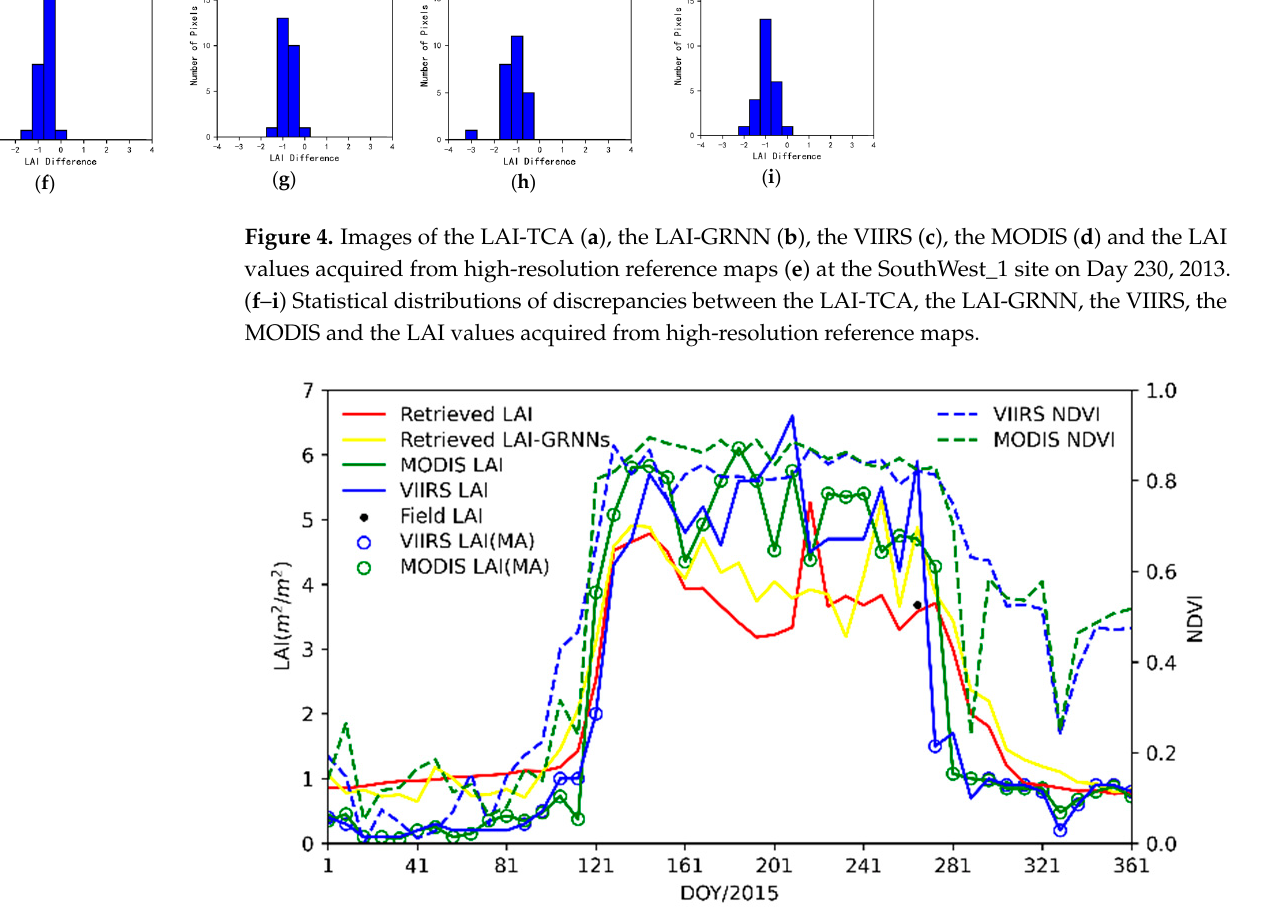
( i ) Figure 6. Images of the LAI-TCA ( a ), the LAI-GRNN ( b ), the VIIRS ( c ), the MODIS ( d ) and the LAI values acquired from high-resolution reference maps ( e ) at the Collelongo site on Day 268, 2015. ( f – i ) Statistical distributions of discrepancies between the LAI-TCA, the LAI-GRNN, the VIIRS, the MODIS and the LAI values acquired from high-resolution reference maps. Figure 6f–i demonstrate the statistical distributions of the discrepancy between the LAI-TCA, the LAI-GRNN, the VIIRS and MODIS LAI values and the reference LAI values at the Collelongo site. Discrepancies between the LAI-TCA and reference LAI values are more concentrated with a smaller standard deviation of 0.62 than discrepancies between the VIIRS LAI values and reference LAI values with a standard deviation of 1.43 and dis- crepancies between the MODIS LAI values and reference LAI values with a standard de- viation of 0.98. The range of discrepancies between LAI-TCA and reference LAI is − 1.0~1.37, whereas the range of discrepancies between VIIRS LAI and reference LAI is − 2.38~2.01 and the range of discrepancies between MODIS LAI and reference LAI is